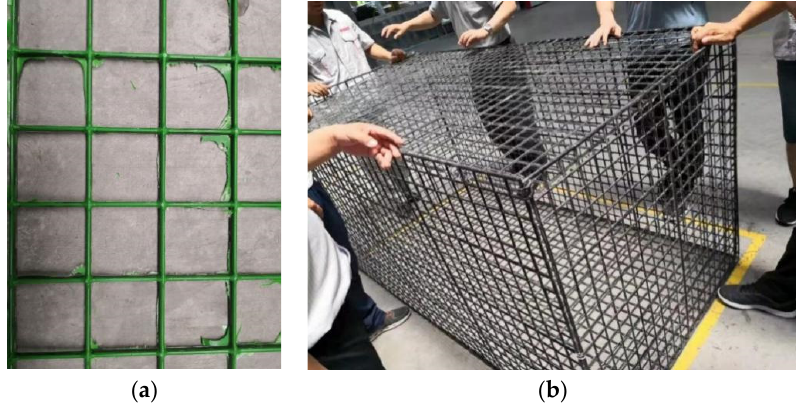
Figure 3. BFR Gabion cage. ( a ) The local model. ( b ) The whole model. Table 2. Basic mechanical parameters.